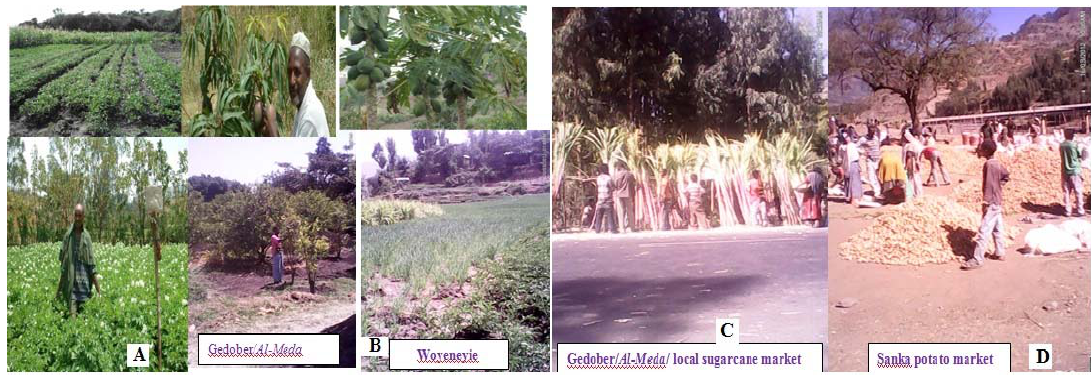
Figure 8. Photos showing wilted sugarcane crop due to water shortage ( A ), and farmers looking for water to irrigate their field ( B ).